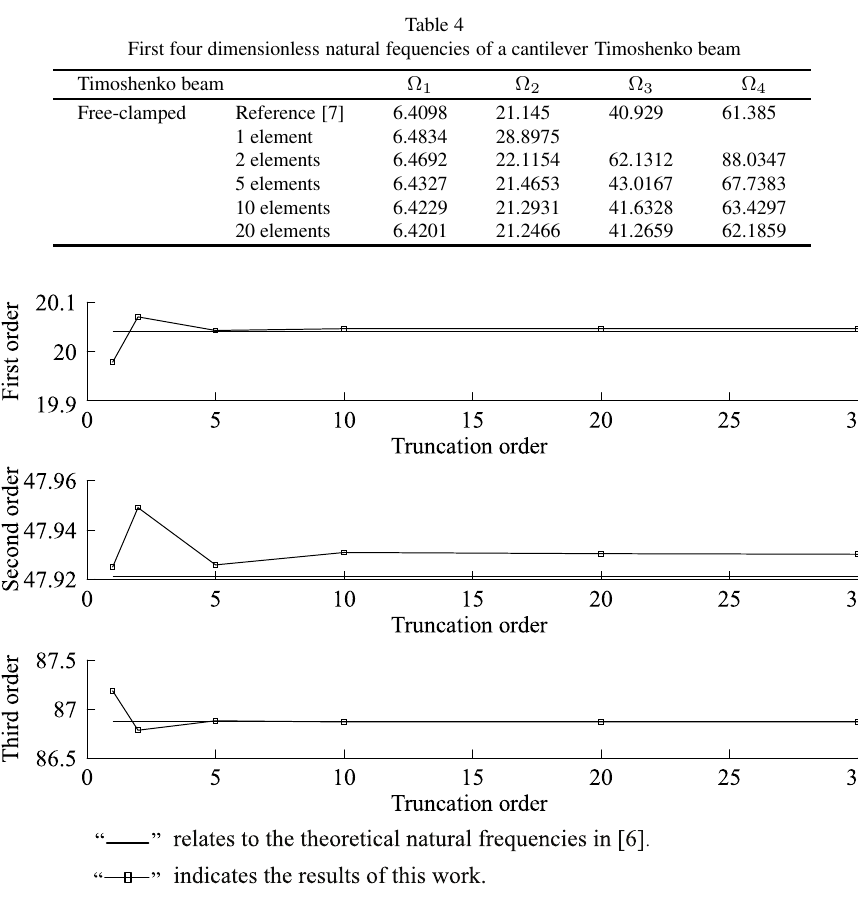
Fig. 6. The variations of first three natural frequencies with the truncation